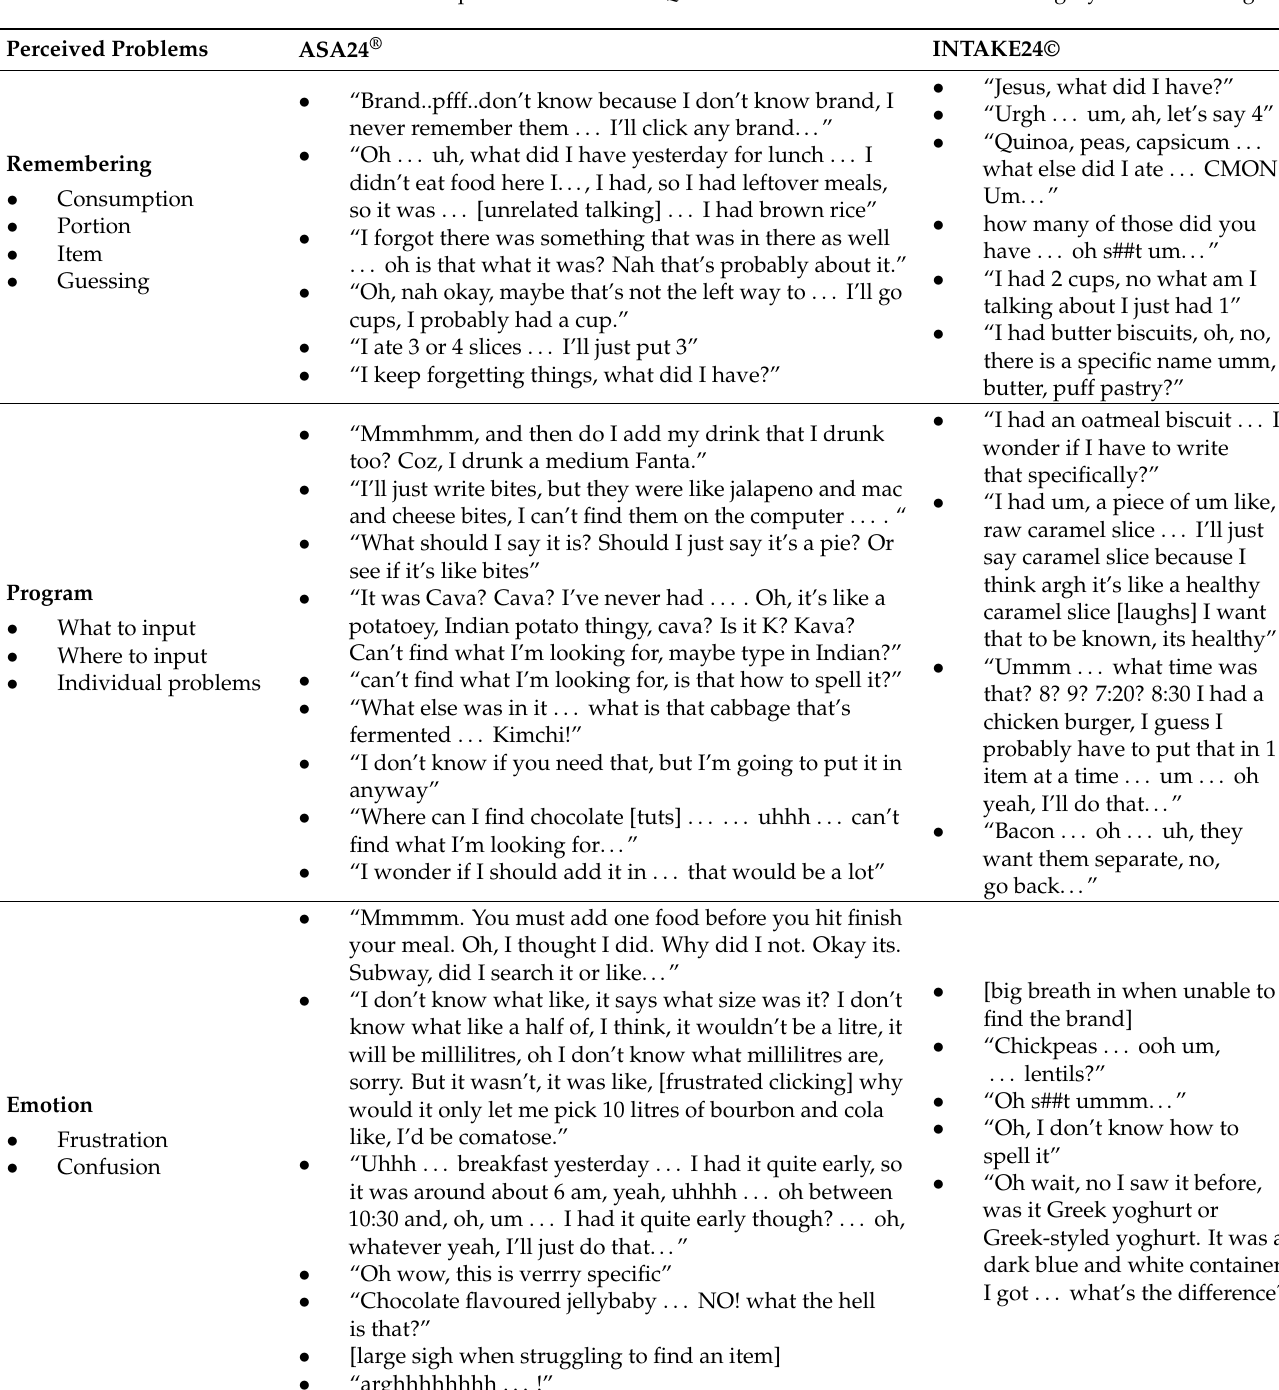
Table 1. Examples of Think-Aloud Quotes for each Perceived Problem Category and 24HR